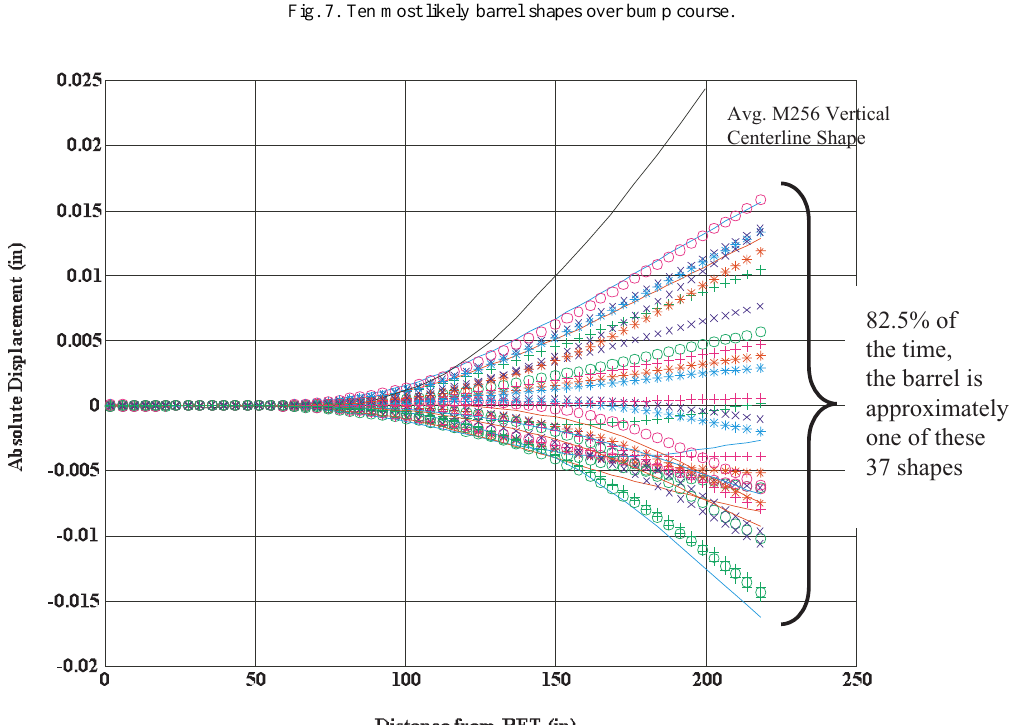
Fig. 7. Ten most likely barrel shapes over bump course.